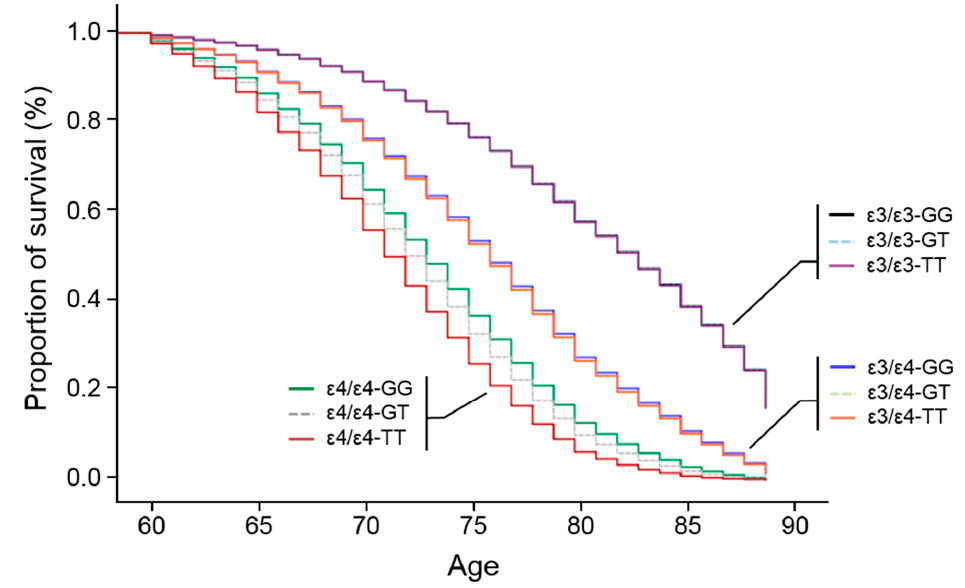
Figure 2. Rs405509 influences age at onset of Alzheimer’s disease. The effect of rs405509 genotype on age at onset was evaluated by survival analysis using Cox regression models adjusted for sex. Curves are shown for individuals with the following APOE isoform and rs405509 genotype combinations: ε 4/ ε 4-TT (dark red line), ε 4/ ε 4-GT (dotted gray line), ε 4/ ε 4-GG (green line), ε 3/ ε 4-TT (orange line), ε 3/ ε 4-GT (dotted light gray line), ε 3/ ε 4-GG (blue line), ε 3/ ε 3-TT (purple line), ε 3/ ε 3-GT (dotted light blue line), and ε 3/ ε 3-GG (black line).